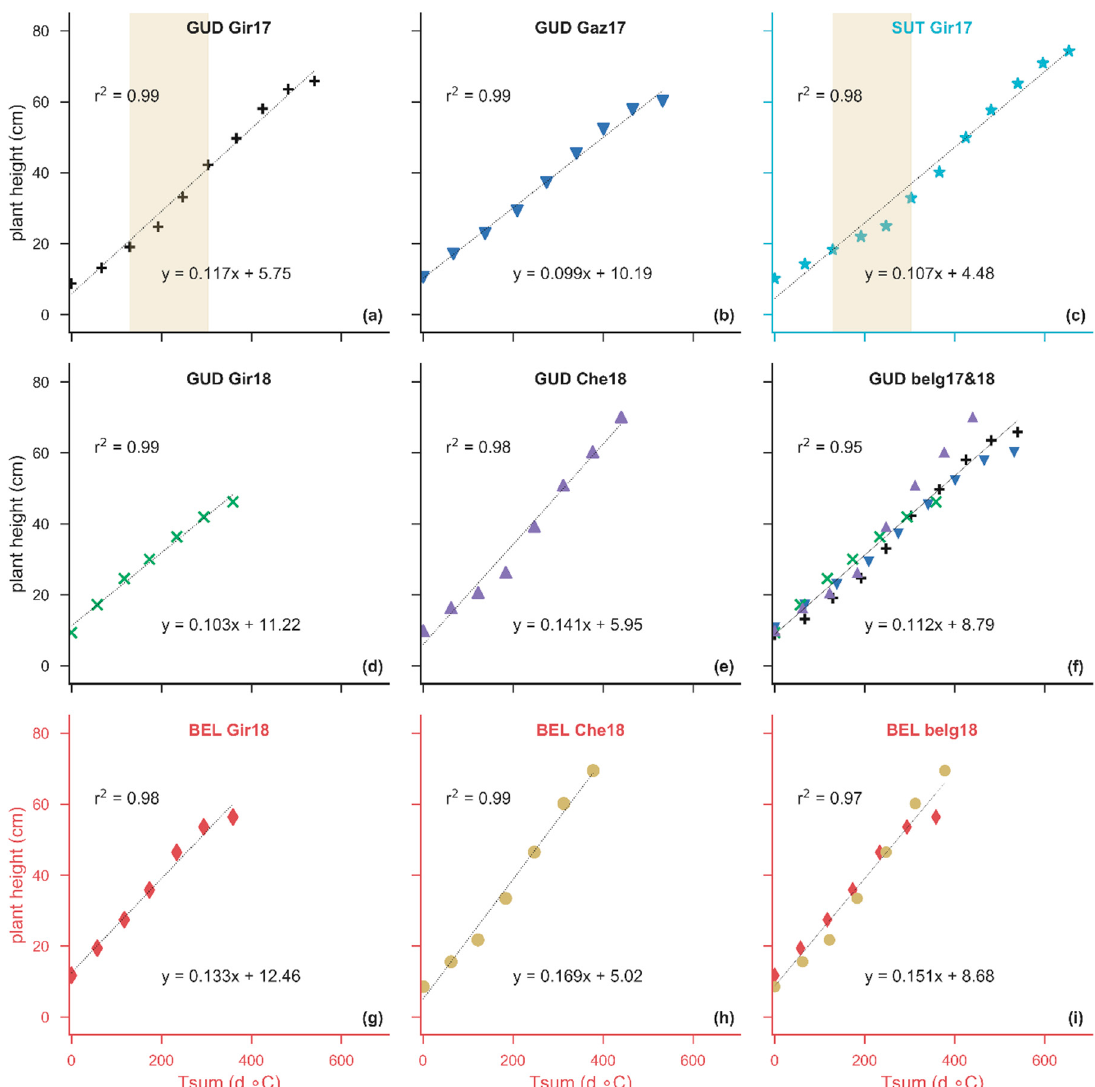
Figure 3. Measured plant height (cm) as a function of Tsum (d ◦ C ) for Gudene (GUD) ( a,b,d,e ) and Belete (BEL) ( g,h ) and Suthalo (SUT) ( c ) during belg -2017 and belg -2018 represented by suffix 17, and 18, respectively. The experimental farms are Gircha (Gir), Gazesso (Gaz) and Chencha (Che). ( f ) and ( i ) show combinations (a series of data combinations for a cultivar for all sites and seasons for linear regression calculation only) of Gudene (black axes) and Belete (red axes) cultivars, respectively. The lines in each plot show the linear function line (plant height = slope × Tsum + intercept); r 2 shows the linear correlation coefficient; and the yellow shades ( a,c ) show a period with dips in the rate of increase in plant height—Tsum curves, which will be discussed in the following